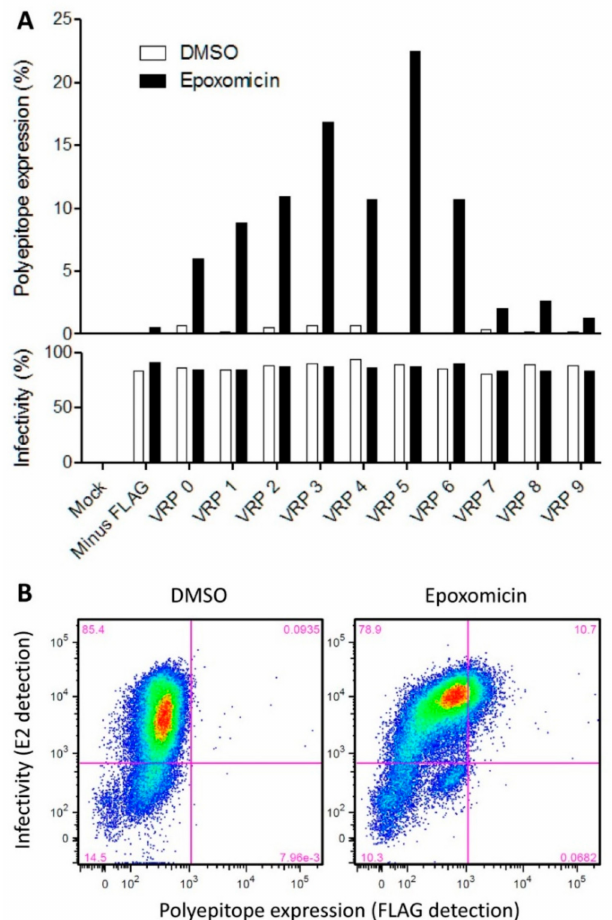
Figure 3. Verification of VRP infectivity and polyepitope expression in SK-6 cells. ( A ) 10 5 cells were infected at a MOI of 5 with the VRPs 0 to 9 or the VRP lacking FLAG (A187-N pro -IRES-C- delE rns ) or mock-infected as control. Twenty-eight hour post-infection cells were treated with the proteasome inhibitor epoxomicin (100 nM) or dimethyl sulfoxide (DMSO). After an additional 17.5 h, the percentage of cells expressing the polyepitope (top panel) and the percentage of infected cells (bottom panel) were determined by FCM using anti-FLAG and anti-E2 antibodies, respectively. At least 36,000 events were acquired for each sample. ( B ) The FCM plots of VRP 6-infected cells under DMSO versus epoxomicin treatment are shown as an